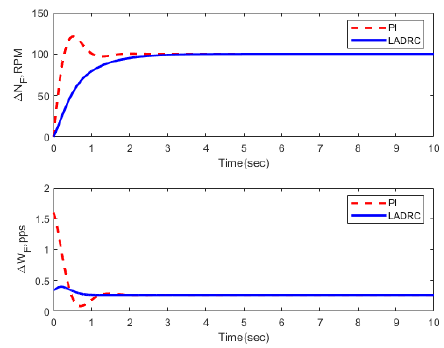
Figure 15. Step response of FC06.